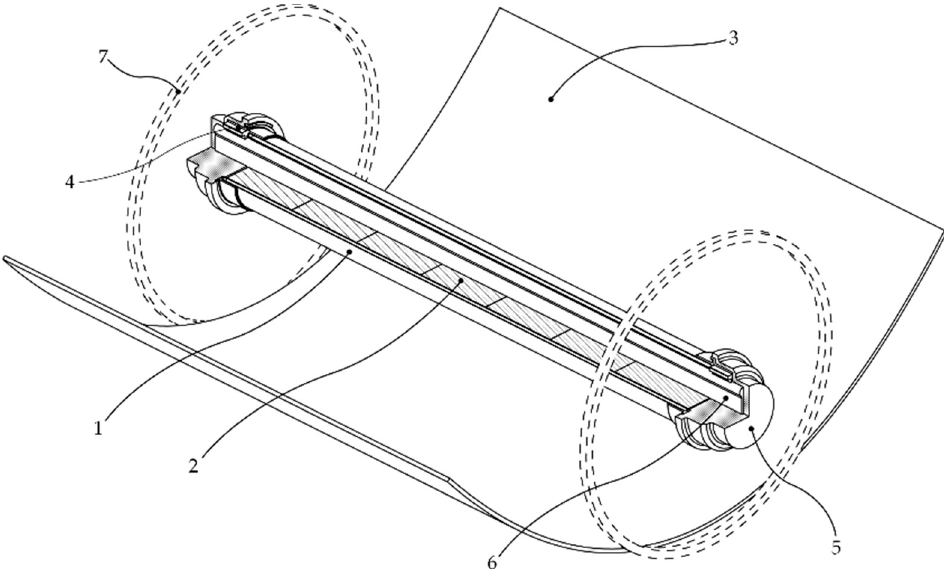
Figure 1. Concentrated solar heater for segmental heat accumulators (1—double-layered solar vacuum tube, 2—heat accumulator, 3—solar radiation parabolic concentrator, 4—heat accumulator support system, 5—thermal insulation block, 6—central beam, 7—chassis (not part of the design). Solar radiation is focused by means of a concentration device attached to the chassis and wheels, respectively, which, however, are not essential from the point of view of the heat accumulation function and have therefore not been detailed in this phase of the design. The sides of the vacuum tube, the supporting system, and the heat storage elements are covered by a heat insulation block eliminating heat losses. The heat accumulators are slid onto a beam which is self-supporting, attached to the hubs of the chassis and the glass tube, as shown in Figure 2. Thanks to this solution, the heat accumulators do not directly load the glass vacuum tube with their weight and the position of their center of gravity is still at one point, which is achieved by the independent mounting of the central beam with respect to the chassis hubs.